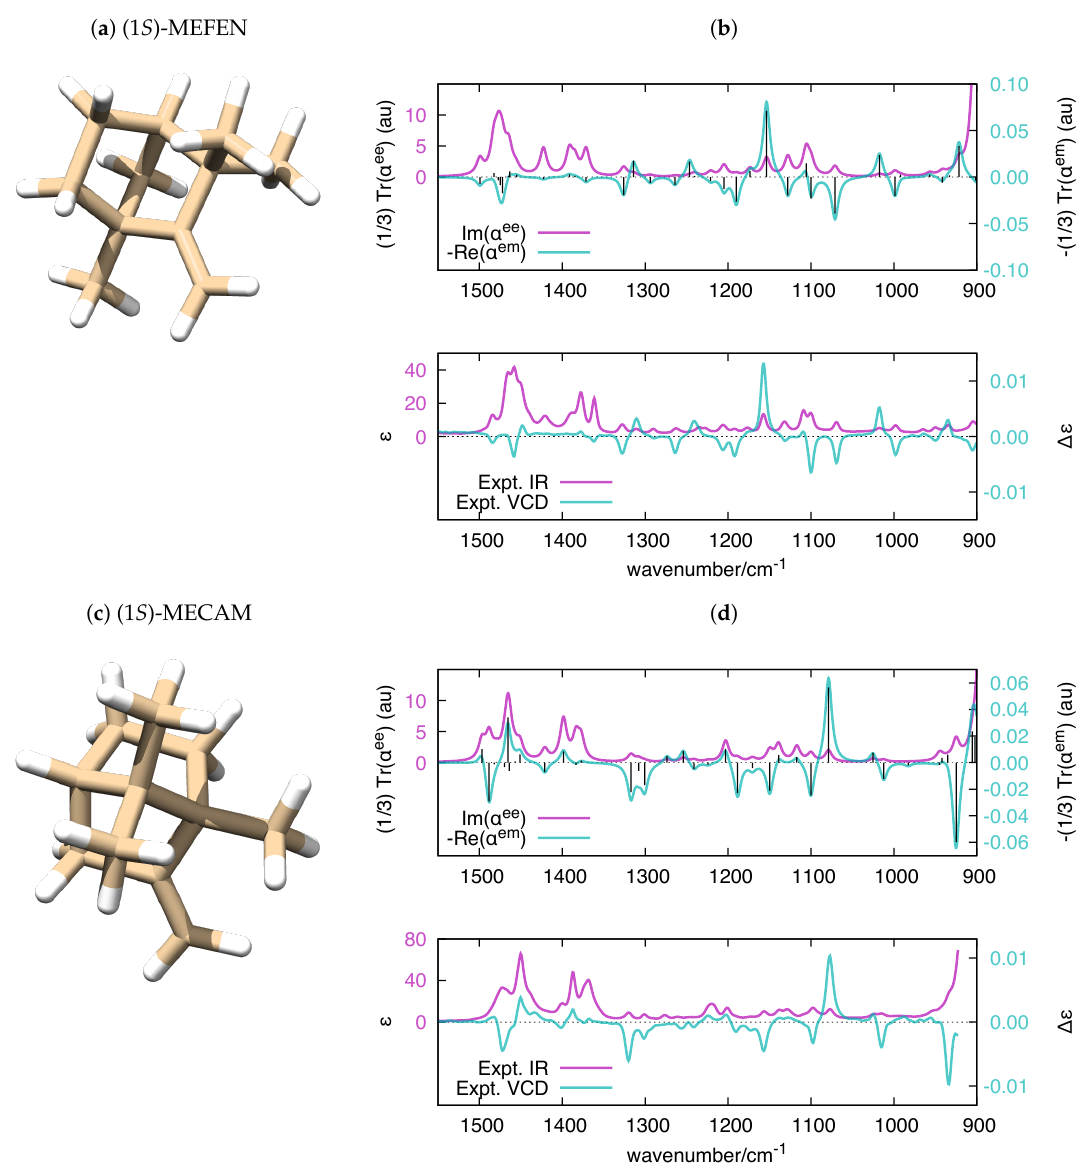
Figure 7. ( a , c ) The equilibrium structure of (1 S )-MEFEN and (1 S )-MECAM, respectively; and ( b , d ) polar -simulated IR and VCD spectra of (1 S )-MEFEN and (1 S )-MECAM ( Γ = 10 cm − 1 ), respectively, compared to their experimental counterparts [79]. The vertical black bars in the top panel are proportional to the rotatory strengths computed by Gaussian ( R 0 k ). To ease the comparison with the experimental data, the wavenumber axis of the simulated polarizabilities has been uniformly scaled by the empirical factor 0.98. DFT calculations were carried out at the B3LYP/aug-cc-pVTZ